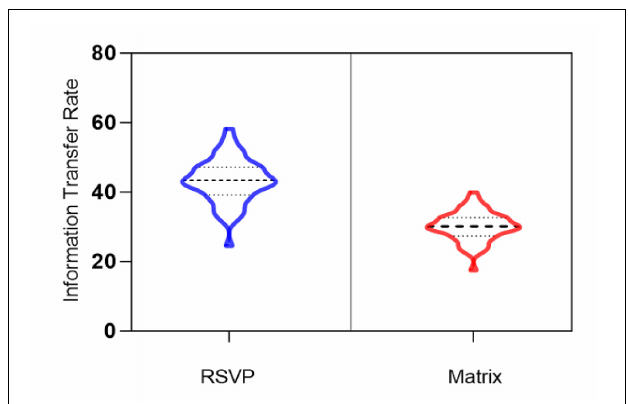
FIGURE 7 | ITR results for the RSVP and matrix paradigms.